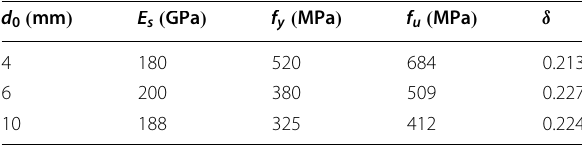
Table 3 Rebar performance indicators.